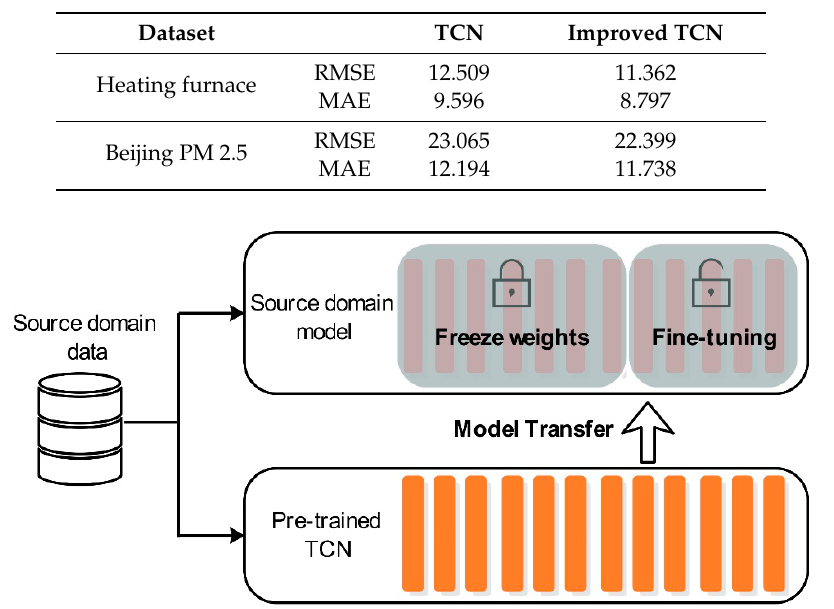
Table 5. Performance of TCN before and after structure improvement.